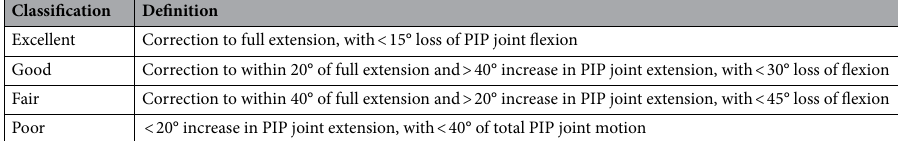
Table 2. The Mayo clinic scoring system proposed by Siegert et al. 6 for treatment outcome. PIP, proximal